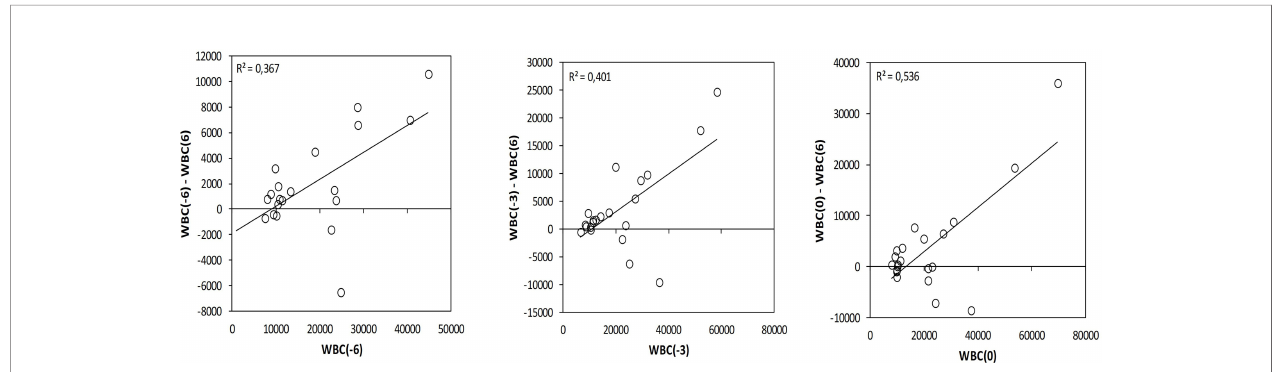
FIGURE 3 | Variation on the white blood cells during the DI2 with High OC/OL - EVOO correlating the differences WBC ( − 6) − WBC (+6) with WBC( − 6), WBC ( − 3) − WBC (+6) with WBC( − 3) and WBC (0) − WBC (+6) with WBC (0) . Linear regression was performed and R 2 is